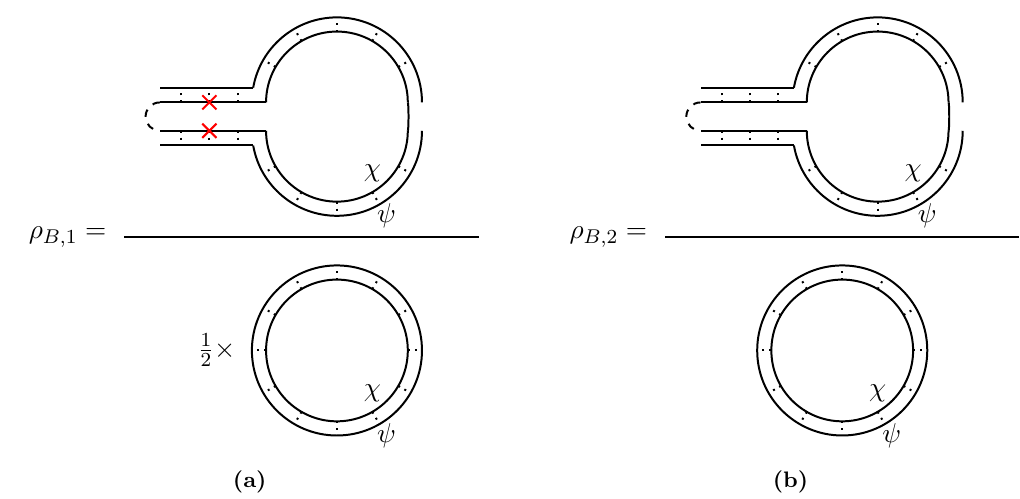
Figure 8. We prepare two density matrices (cid:26) B; 1 and (cid:26) B; 2 , where for (cid:26) B; 1 we inserted a fermion operator (cid:31) i at time t 0 (represented by the red crosses). In the (cid:12)gure, the denominators are the proper normalization factors, while the factor 1 = 2 comes from (cid:31) 2